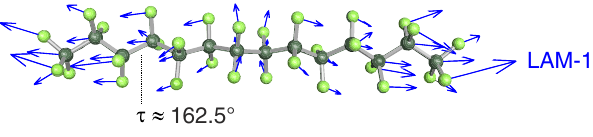
Figure 1. Minimum energy structure of C 14 F 30 on the B3LYP-D3/ def2-TZVP level. All CC torsion angles ( τ ) are close to 163°, sim- ilar to the 13/6 helix in the solid [10]. Blue arrows indicate the calculated LAM-1 normal